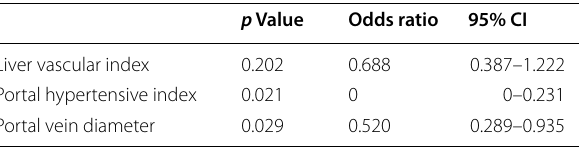
Table 7 Logestic regression model to predict the presence of esophageal varices in the studied groups